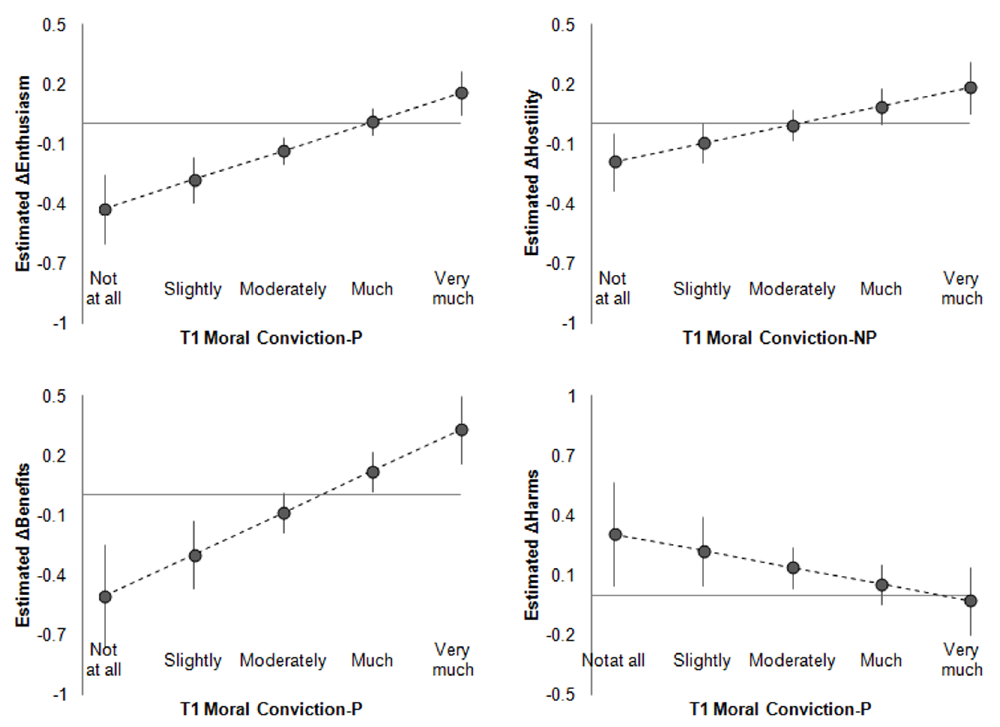
Figure 5. Estimated Change in Affect and Beliefs at Levels of Time 1 Moral Conviction. Note. Error bars are 95% confidence intervals of the estimated change. All estimates based on the model reported in Figure 4 and Table S3 in the Supplemental